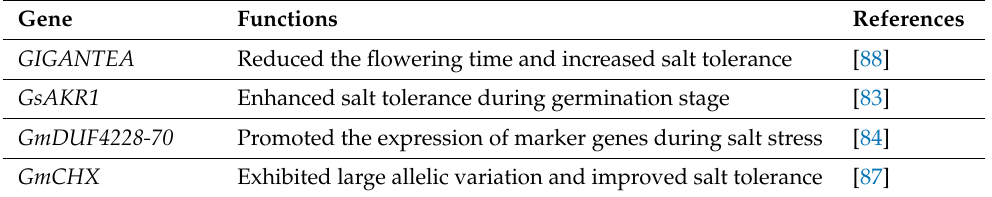
Table 4. GWAS-based identified genes for salt tolerance in soybean. Gene Functions